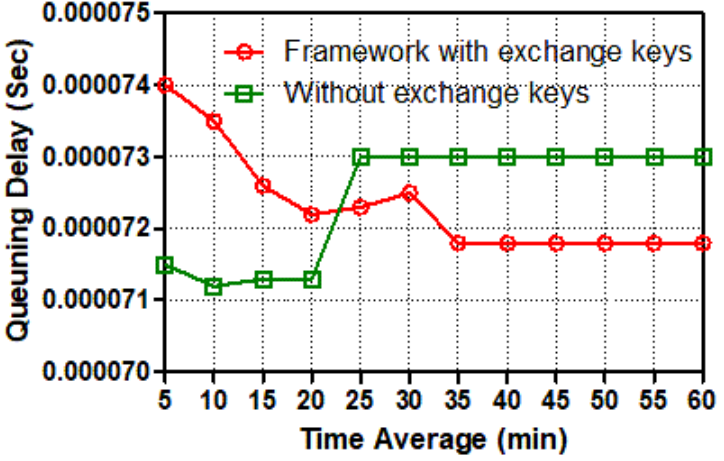
Figure 7. Throughput (packets/s) from a smart meter to the switch for different tasks.